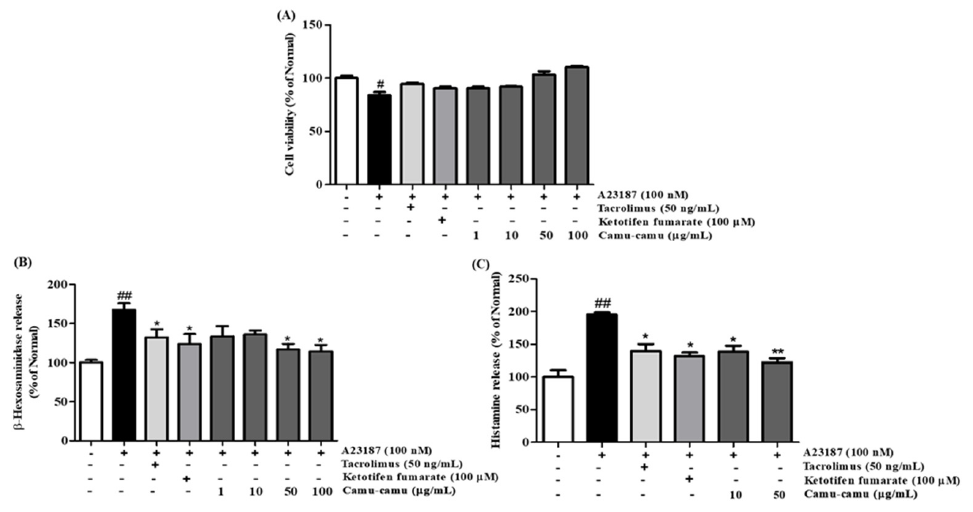
Figure 2. Effect of camu-camu fruit extract on cell viability ( A ), β -hexosaminidase ( B ), and histamine release ( C ) in A23187-induced RBL-2H3 cells. Tacrolimus and ketotifen fumarate were employed as positive controls. All data are displayed as mean ± standard deviation (SD) of three independent experiments ( # p < 0.05 and ## p < 0.01 vs. the control group, * p < 0.05 and ** p < 0.01 vs. the A23187-treated group).